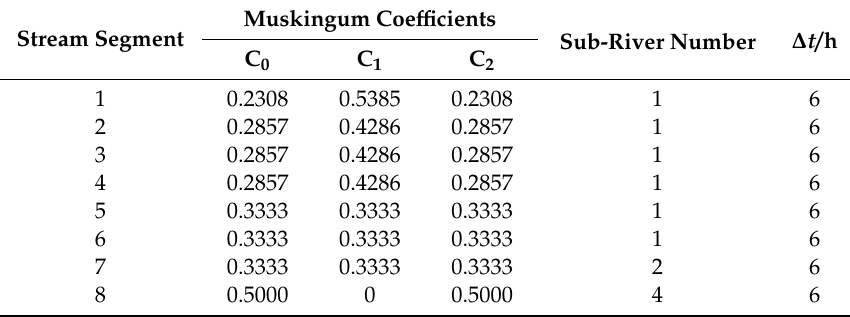
Table 2. The Muskingum method coefficients for flood routing.